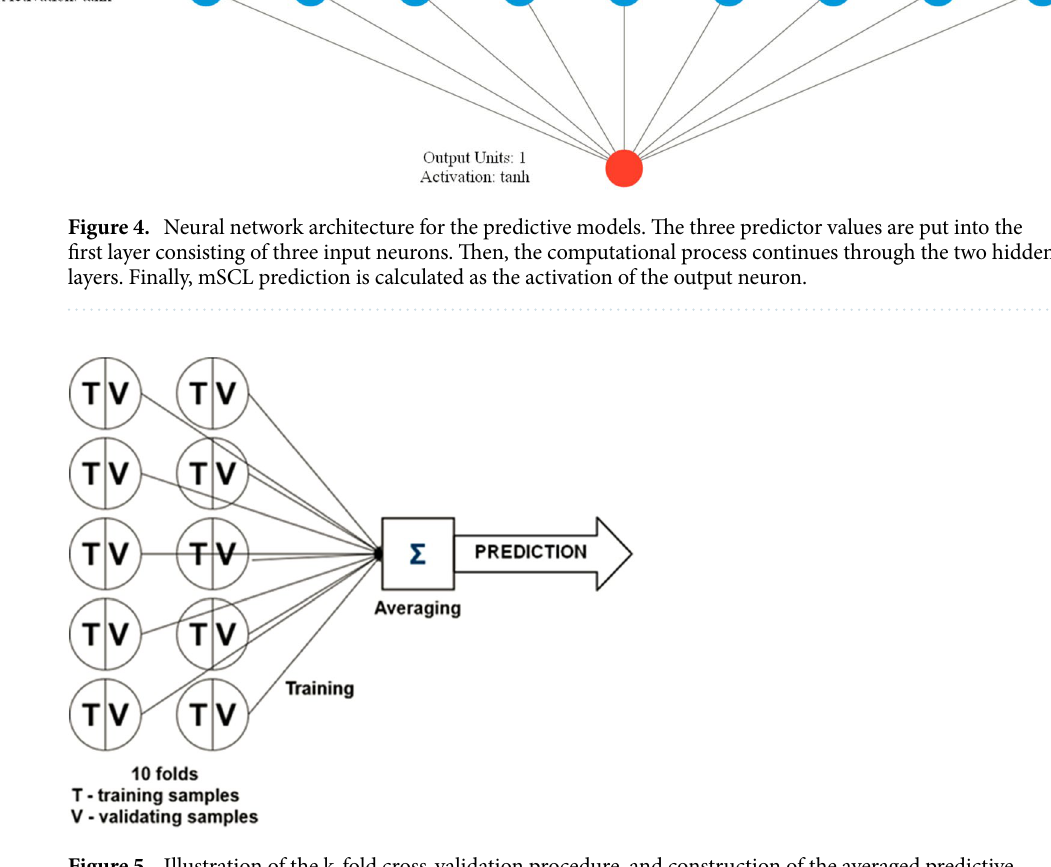
Figure 5. Illustration of the k-fold cross-validation procedure, and construction of the averaged predictive